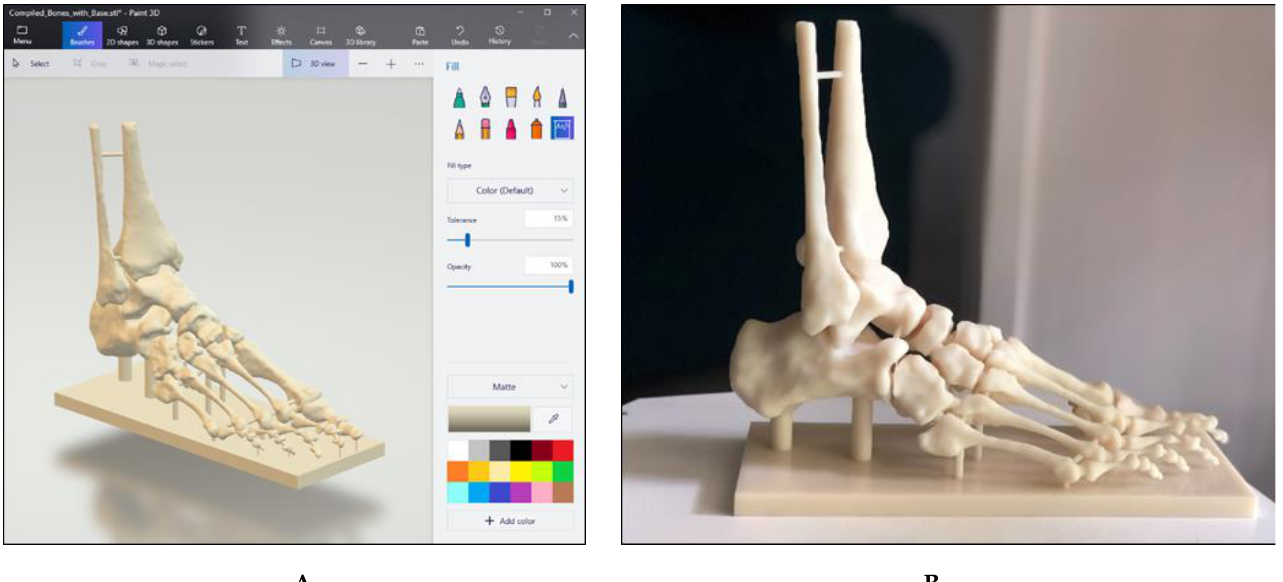
Figure 8. Virtual and 3D printed bony models. ( A ) Bony model in .STL file with painted connections and supporting base. ( B ) Life-size model printed in white Visijet SL Flex (Polyjet 6000 HD, 3D Systems, Melbourne, Australia) with supporting base.